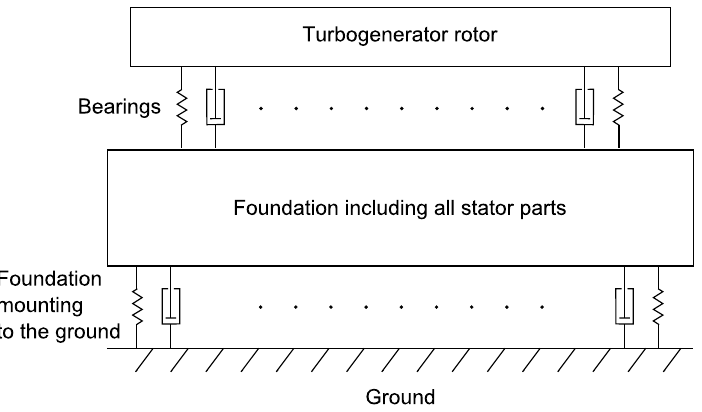
Figure 1. The general structure of a whole turboset